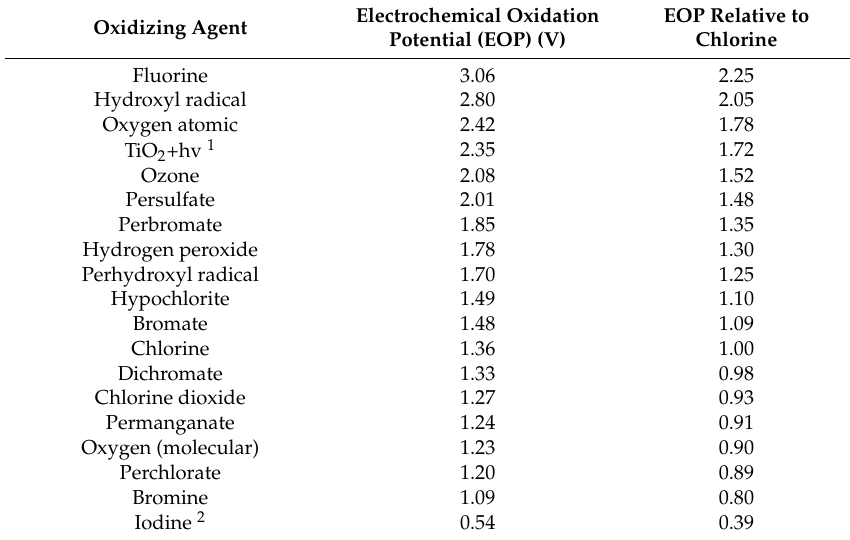
Table 2. A comparison of the oxidizing potential of various oxidants.